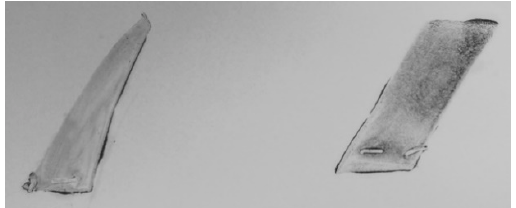
Figure 12. Experimental example for tyre contact